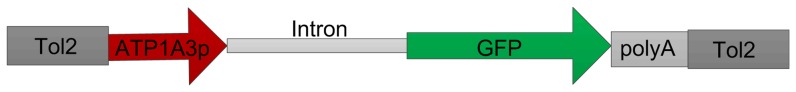
Schematic representation of elements in the minimal Tol2-vector construct, Tol2-pATP1A3:GFP, used for transgenesis in zebrafish.This construct is modified from the pT2AL200R150G plasmid [70]. Tol2: the left and right terminal regions of the full-length Tol2, ATP1A3p: the porcine ATP1A3 promoter sequence, GFP: Green Fluorescence Protein, Intron: the rabbit β-globin intron, polyA: SV40 polyA signal.